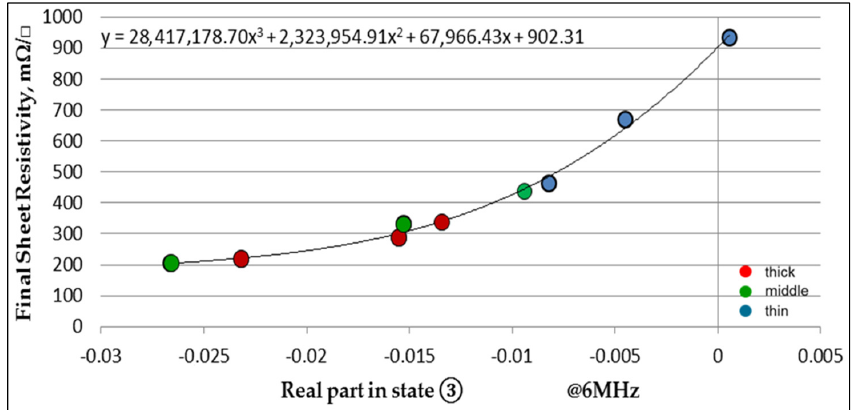
Figure 12. Correlations between the final sheet resistivity and real part in state (3) at a frequency of 6 MHz for glass/Ag films.